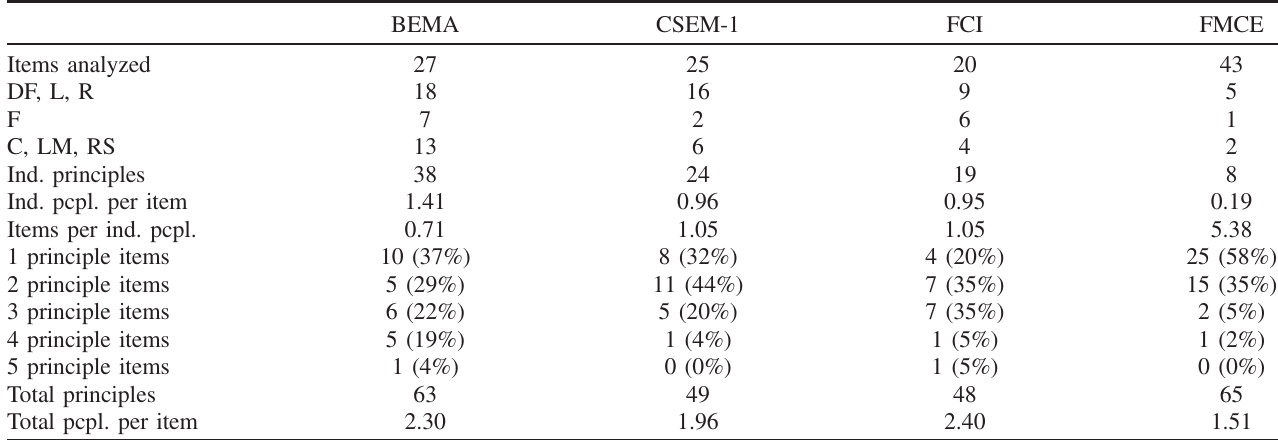
TABLE VIII. Comparison of conceptual instruments. DF, L, R, F, C, LM, and RS represent principles in each instrument. Independent is abbreviated “ ind ” and principle “ pcpl ” when needed for